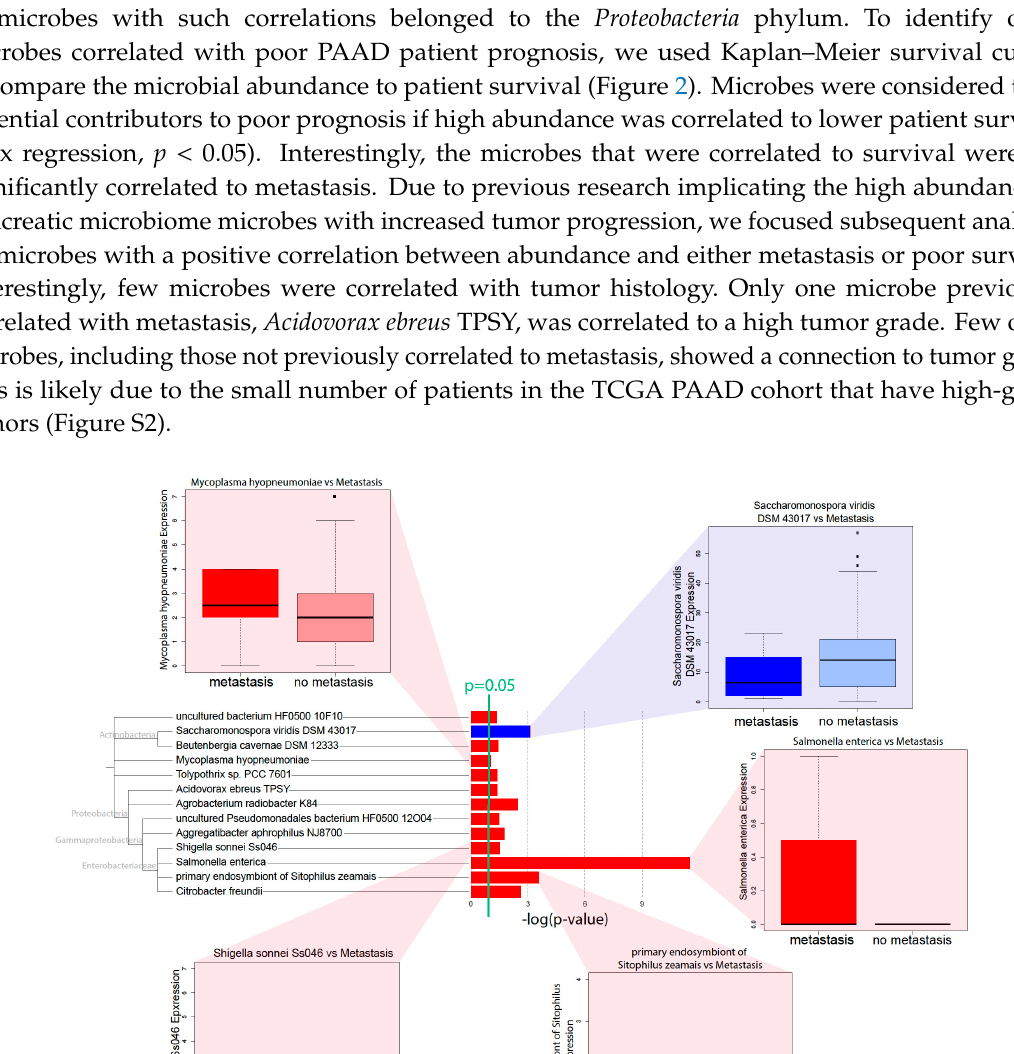
Figure 1. Contamination correction of TCGA data. A summary of the three contamination correction methods used: filtering for common contaminants, microbes with little variation in abundance across patients, and microbes with unusually high abundance corresponding to specific dates.